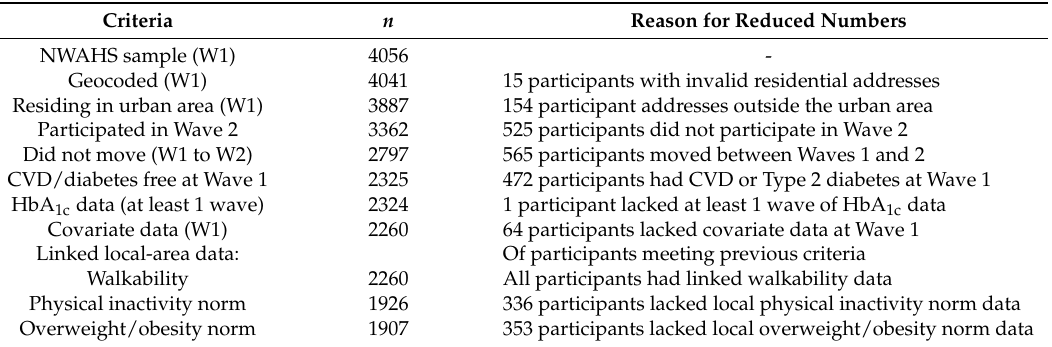
Table 1. Inclusion criteria and derivation of the three analytic